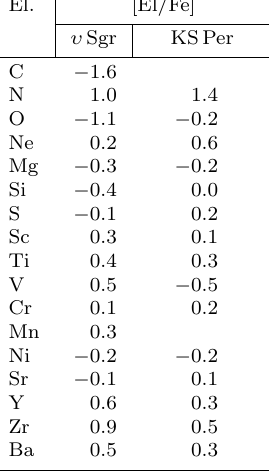
Table 3. The normal- ized abundances [El/Fe] of chemical elements of υ Sgr compared to those of KS